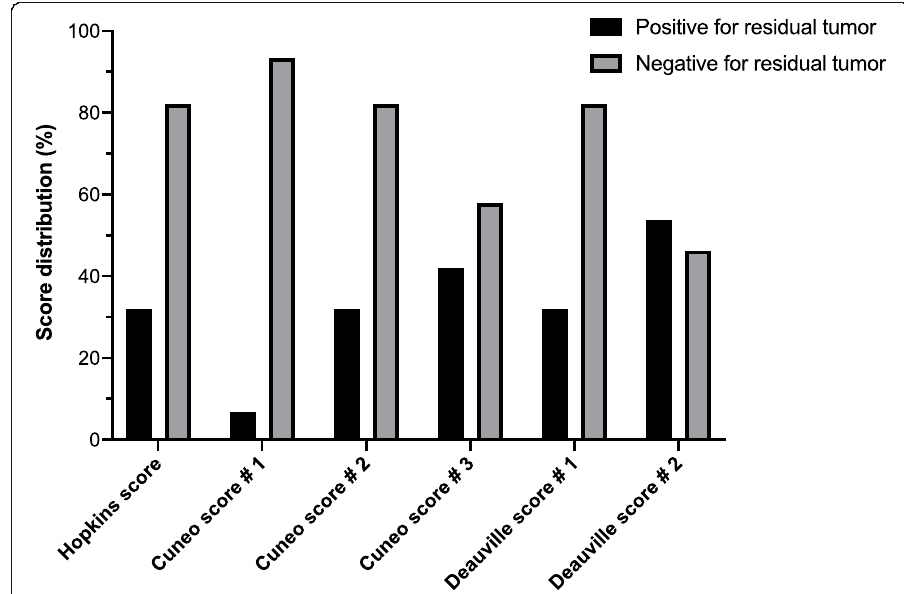
Fig. 2 Score distribution of FDG-PET/CT post-treatment scans according to used standardized reporting criteria (Deauville, Hopkins and Cuneo scores). Post-treatment scans classified as positive or negative for residual tumor (black and grey bars, respectively) based on composite TNref score